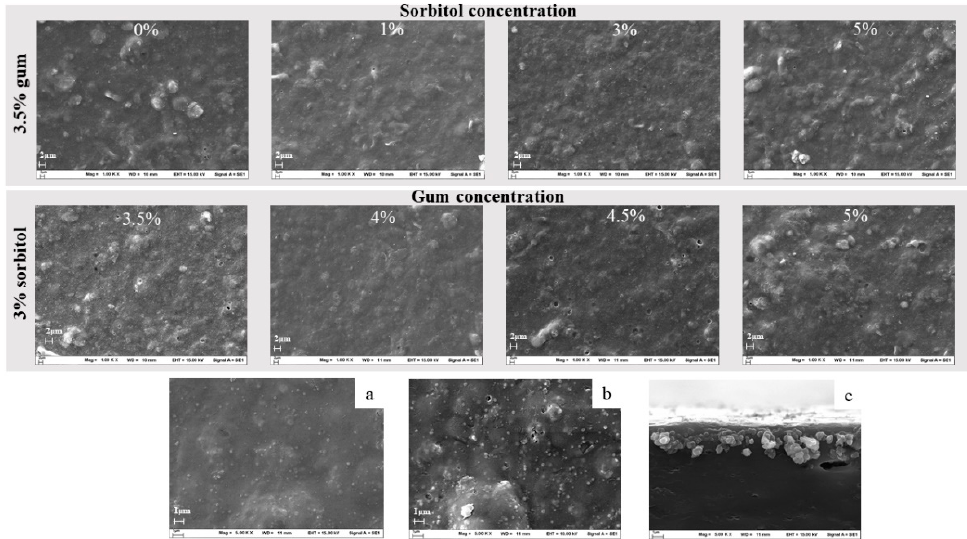
Figure 3. Scanning electron microscope images of printing substrates prepared from different concentrations of sorbitol and gum, and also comparison of ( a ) non-printed, ( b ) printed substrate surfaces and ( c ) a cross-sectional view of the printed substrate at 3.5% gum and 3% sorbitol.